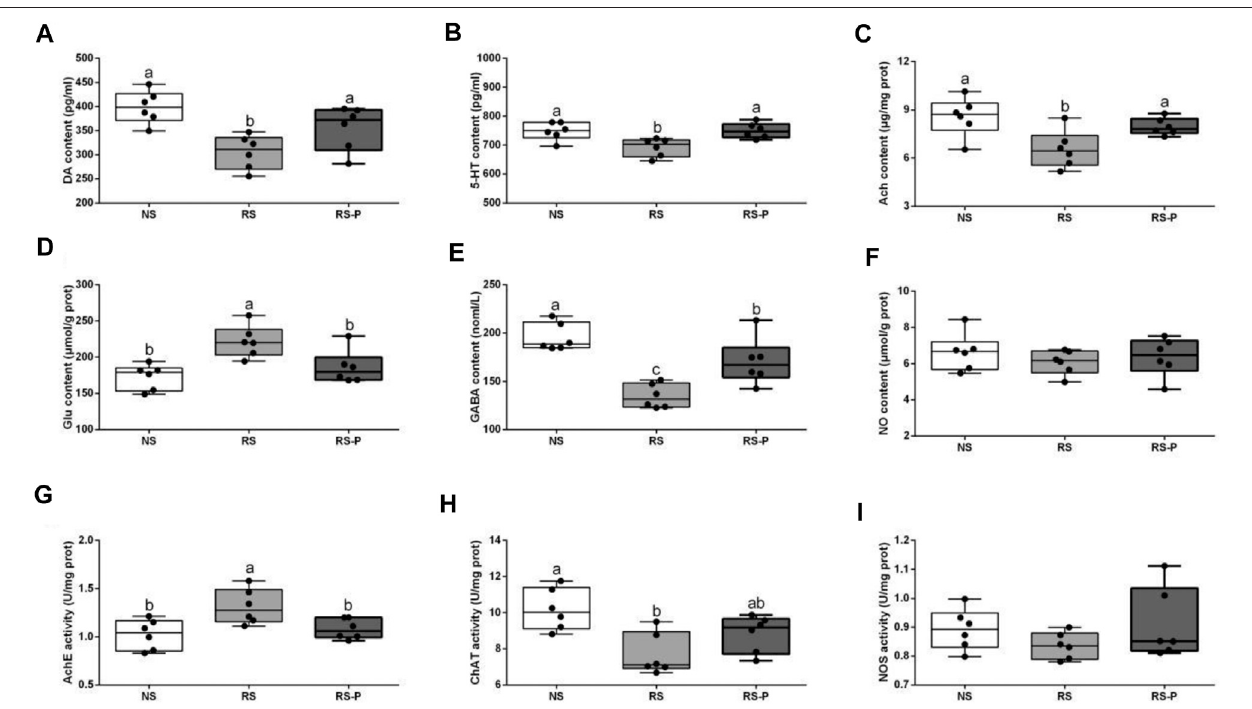
FIGURE 7 | Levels of neurotransmitters in the hippocampus. Data are presented with the means ± standard deviation ( n (cid:2) 6). Bars with different letters are signi fi cantly different on the basis of Duncan ’ s multiple range test ( P < 0.05). (A) – (F) : Levels of DA, 5-HT, Ach, Glu, GABA and NO, respectively; (G) — (I) : Activities of AchE, ChAT and NOS, respectively. DA, dopamine; 5-HT, 5-hydroxytryptamine; Ach, acetylcholine; Glu, glutamic acid; GABA, gamma-aminobutyric acid; NO, nitric oxide; AchE, acetyl-cholinesterase; ChAT, choline acetyltransferas; NOS, nitric oxide